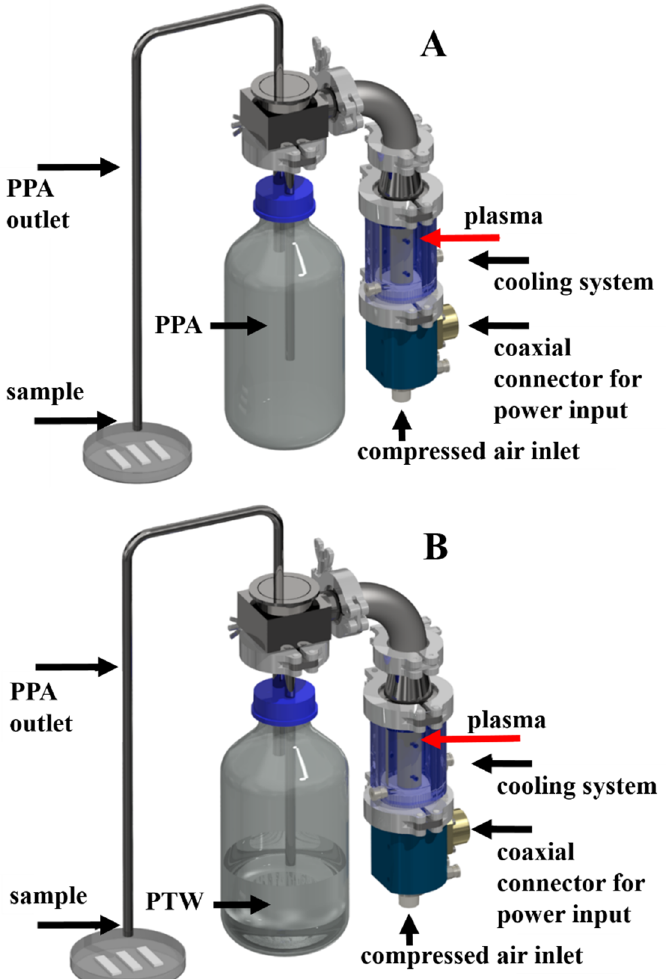
Figure 1. Scheme of the microwave-setup for ( A ) the generation of PPA (plasma-processed air) and ( B ) the functionalization of PTW (plasma-treated water).